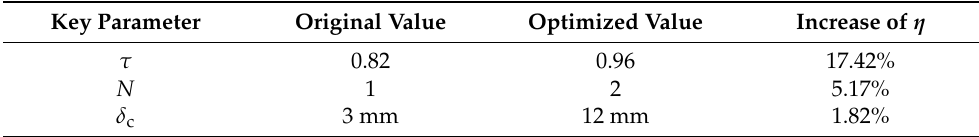
Table 3. Sensitivity analyses of τ , N, and δ c .